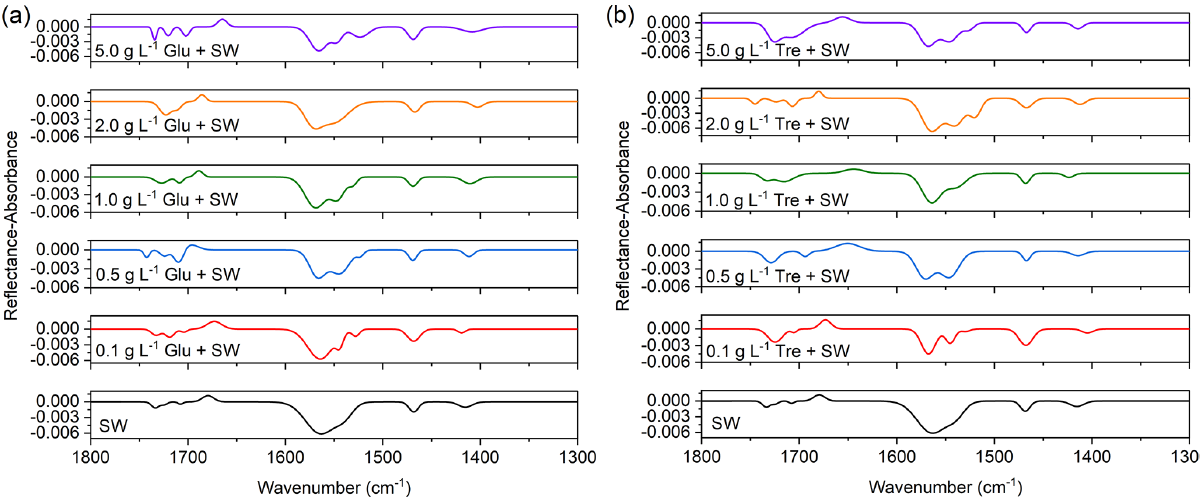
Figure 6. PM-IRRAS spectra (1800–1300cm − 1 ) of mixed fatty acids at the air/seawater interface at different (a) glucose and (b) trehalose concentrations in the